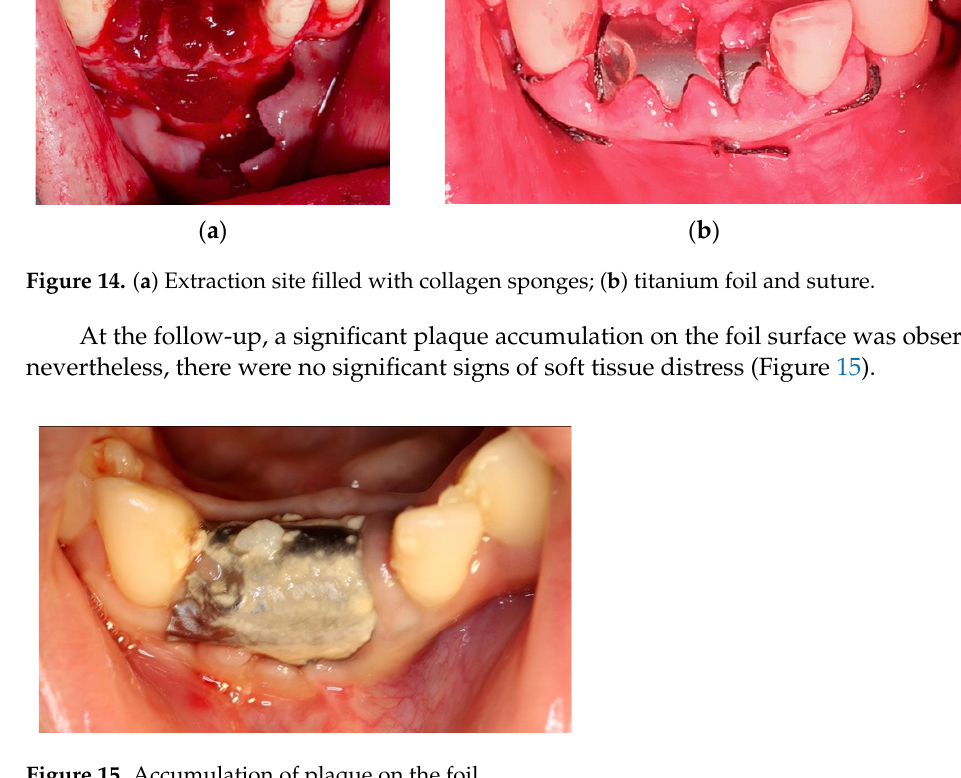
Figure 13. ( a ) Cystic lesion between lower incisors; ( b ) full-thickness flap, extraction of the three incisors and removal of the cyst.